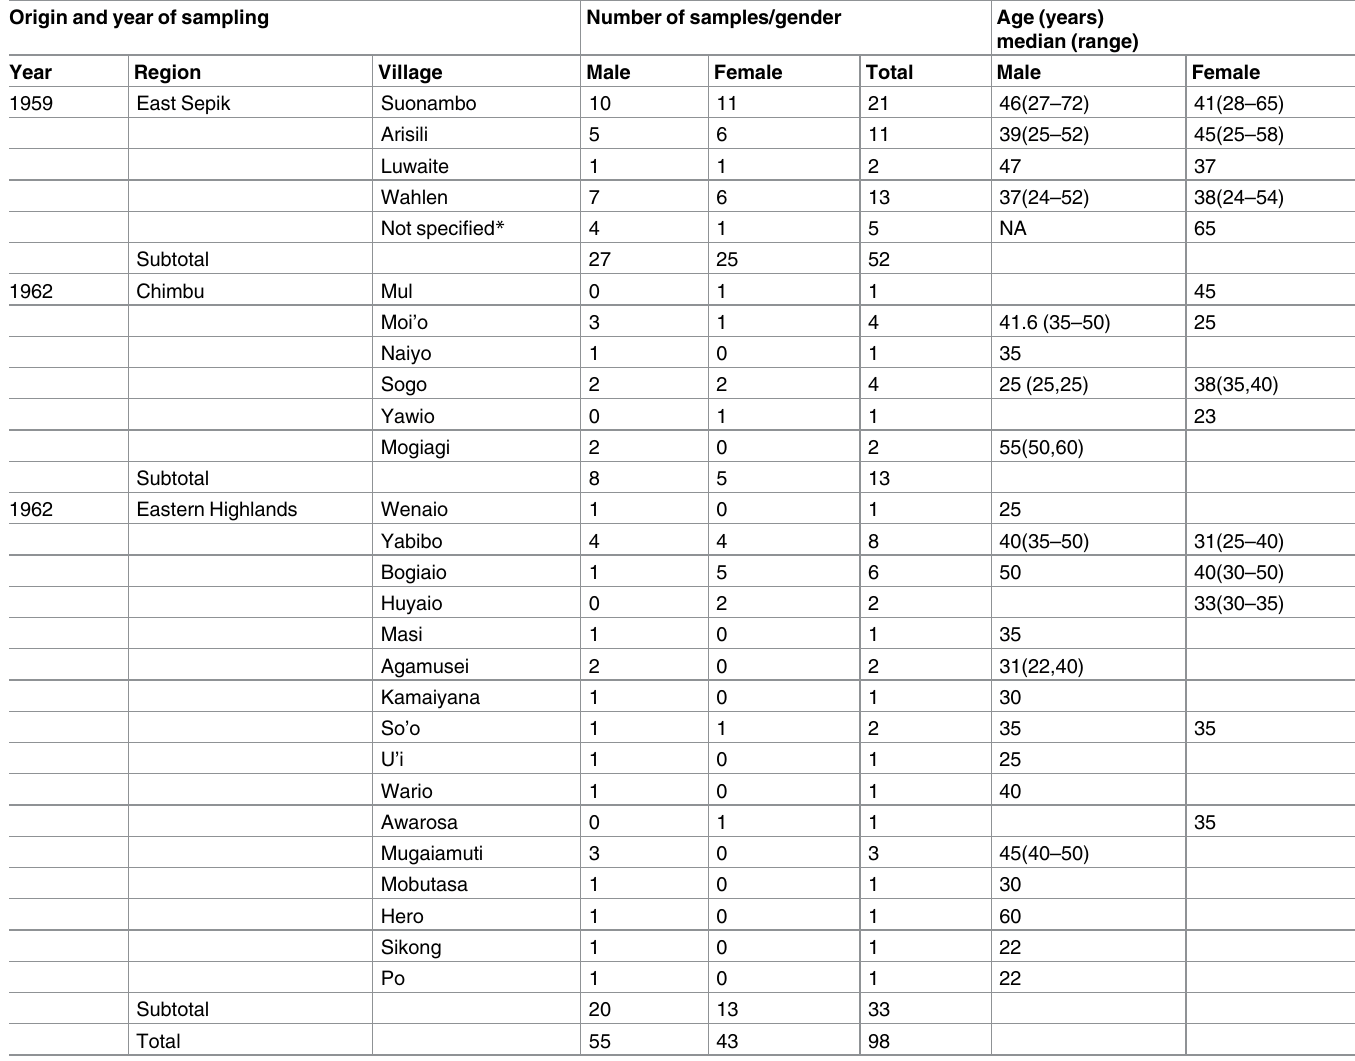
Table 1. Study population, Papua New